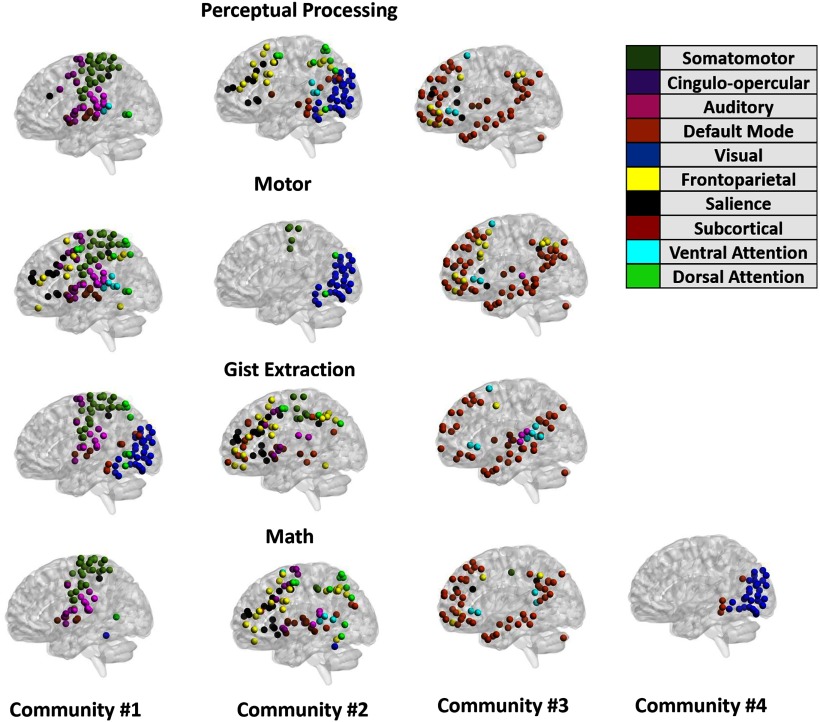
The group-based consensus partitions for each task mode under scrutiny. Network labels are based on Power et al. (2011). The brain networks were visualized with the BrainNet Viewer (http://www.nitrc.org/projects/bnv/; Xia et al., 2013).